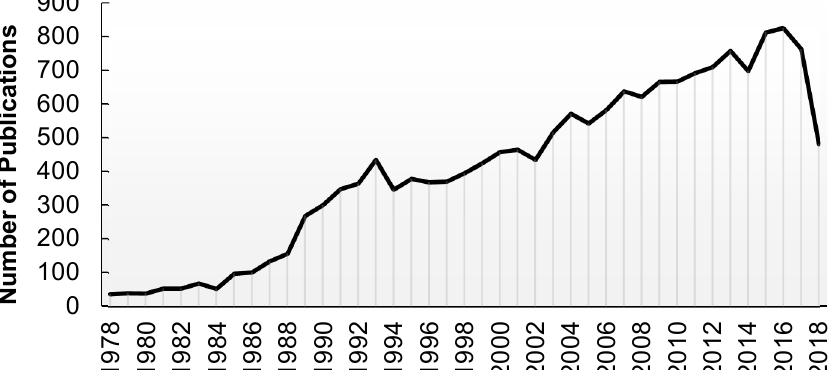
Figure 1. Literature search on Pubmed for the terms related to cardiac ischemia tissue injury show 16,752 publications since 1978. Search details: (“heart”[MeSH Terms] OR “heart”[All Fields] OR “cardiac”[All Fields]) OR (“ischaemia”[All Fields] OR “ischemia”[MeSH Terms] OR “ischemia”[All Fields]) OR (“tissues”[MeSH Terms] OR “tissues”[All Fields] OR “tissue”[All Fields]) OR (“wounds and injuries”[MeSH Terms] OR (“wounds”[All Fields] AND “injuries”[All Fields]) OR “wounds and injuries”[All Fields] OR “injury”[All Fields]) AND (“1978/01/01”[PDAT]: “2018/11/29”[PDAT]): https://www.ncbi.nlm.nih.gov/pubmed/ ; site visited on November 29, 2018.